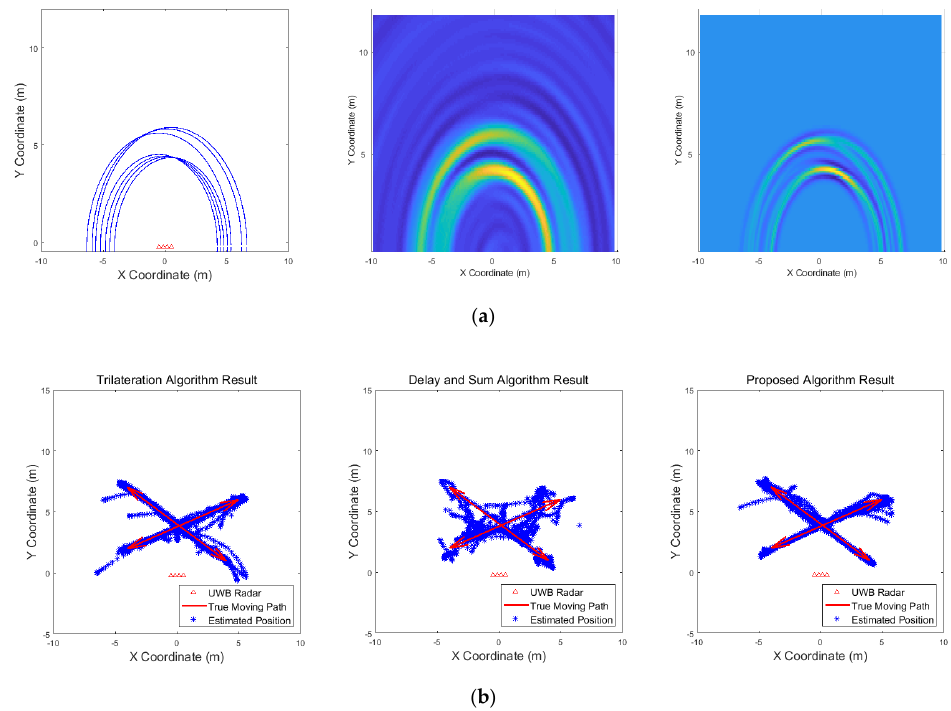
Figure 15. Simulation results when two targets move cross over (Scenario 7): ( a ) instantaneous results of position estimation step according to the positioning algorithm; ( b ) results of the radar system for the entire simulation. Sensors 2019 , 19 , x FOR PEER REVIEW